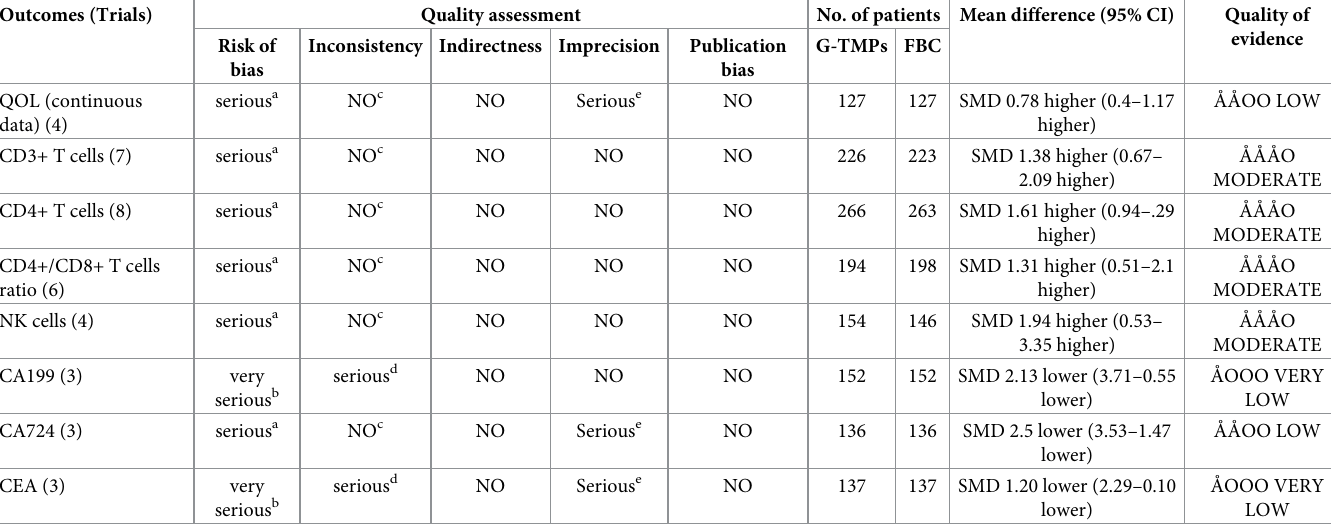
Table 9. GRADE evidence profile of QOL (continuous data), peripheral blood lymphocyte levels and cancer